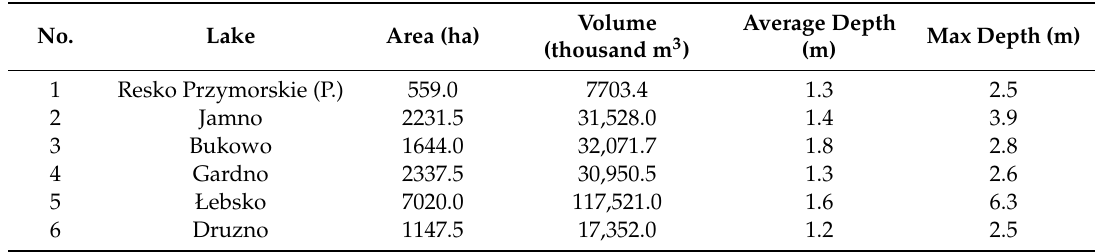
Table 1. Morphometric data of the studied lakes.